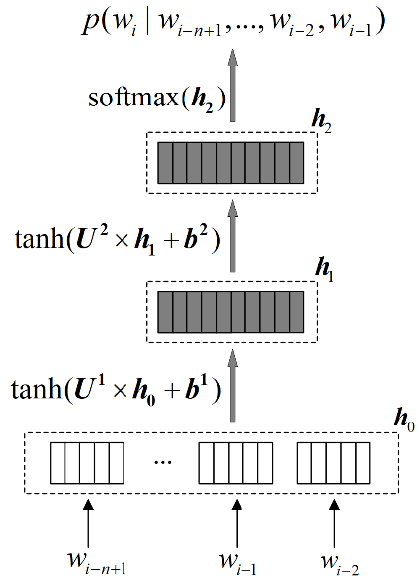
where e ( w i − 1 ) ∈ R d represents the d -dimensional word vector corresponding to word w i − 1 . The word vector matrix L can be initialized randomly at the beginning and optimized as a parameter during model training.